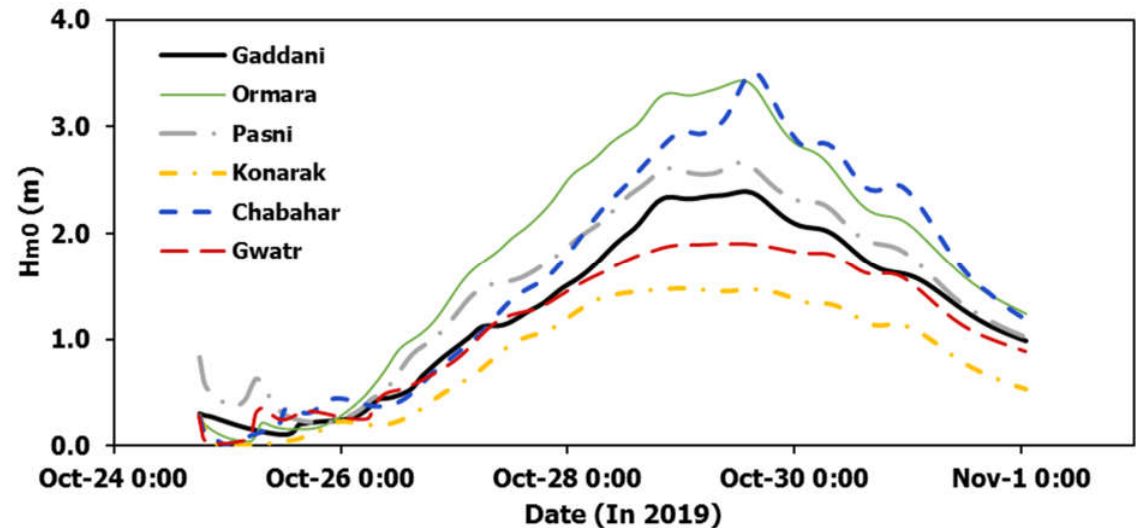
Figure 14. Significant wave heights along the Iranian and Pakistani coastlines during tropical cyclone Kyarr.